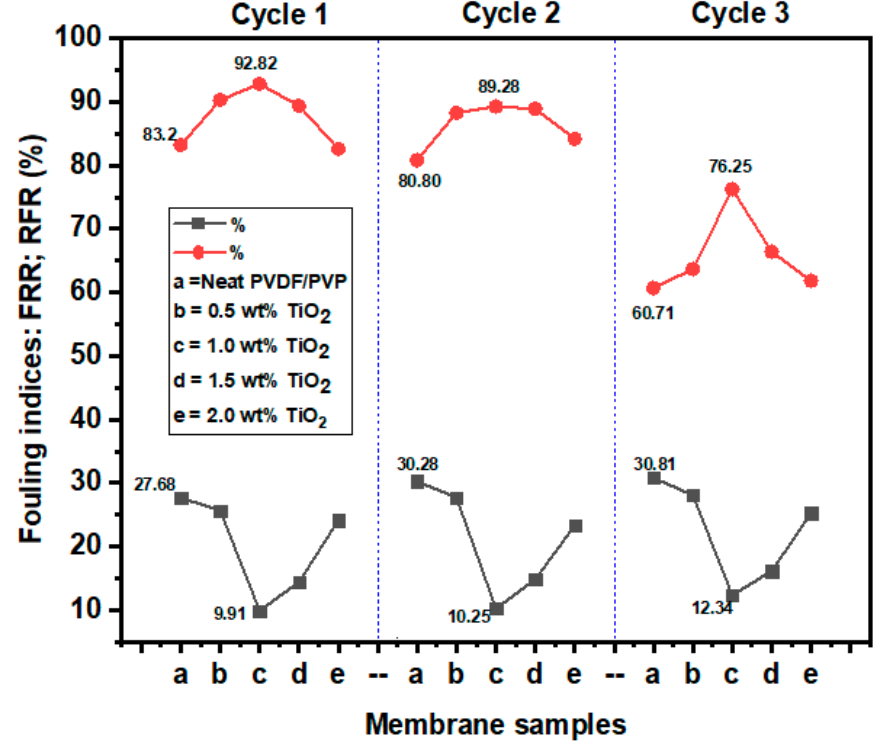
Figure 10. Percent relative flux reduction (%RFR) and percent flux recovery ratio (%FRR) in three filtration cycles using leachate as feed.